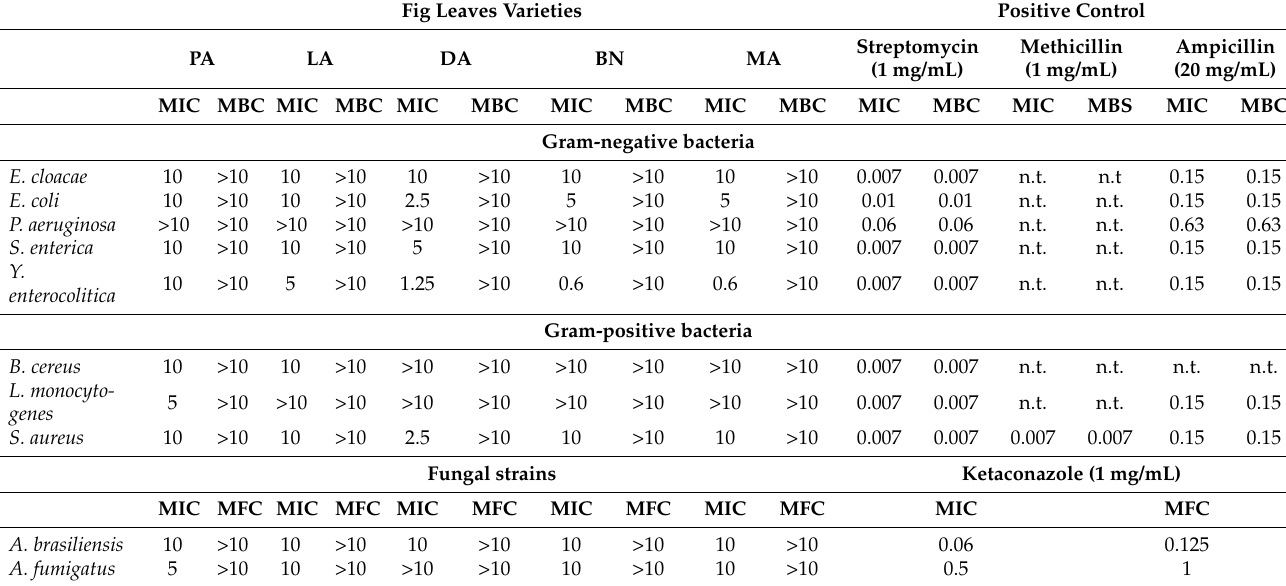
Table 8. Antimicrobial activity against food micro-organisms. Fig Leaves